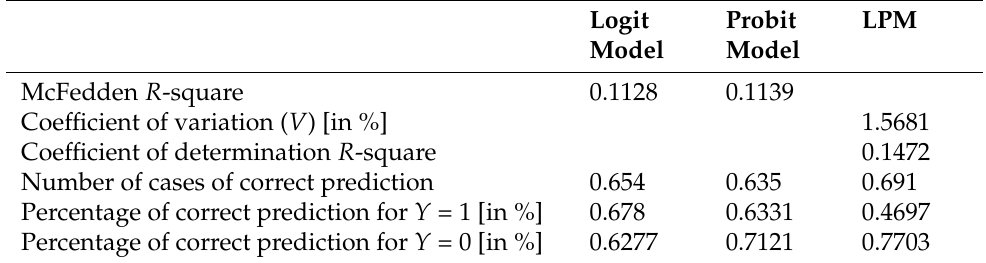
Table 9. Comparison of model fit to empirical